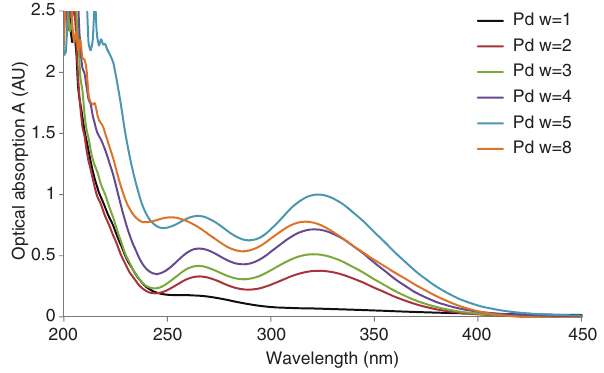
Figure 4 Absorption spectra of Pd RadChem NPs (Dose = 30 kGy, ω = 5.0.) in reversed micellar solutions at different moments, t, min: . 0 – upper curve, 70 – lower i